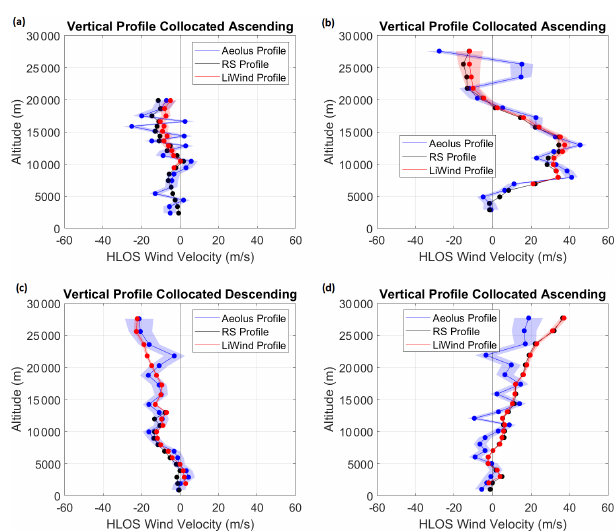
Figure 5. Wind velocity profiles measured by the radiosonde (black) with the closest Aeolus Level 2B Rayleigh clear (blue) and ground-based lidar (red) profiles. The lidar and radiosonde profiles are shown with an adjusted resolution to the Aeolus range bin width. The lidar and radiosonde measurements are projected to the HLOS of Aeolus. (a) 24 February 2021 (AboVE Maido 2), (b) 9 June 2021 (AboVE Maido 2), (c) 14 December 2021 (AboVE OHP 2), and (d) 20 December 2021 (AboVE OHP 2). The shading represents the internal estimated error for each